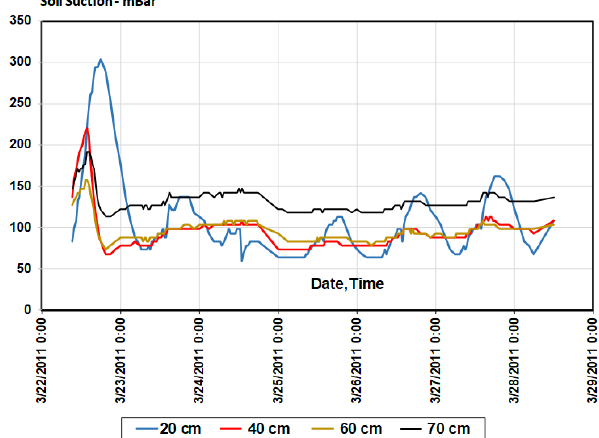
Figure 8. Soil suction on the different depths of the soil profile mea- sured at the first tensiometer